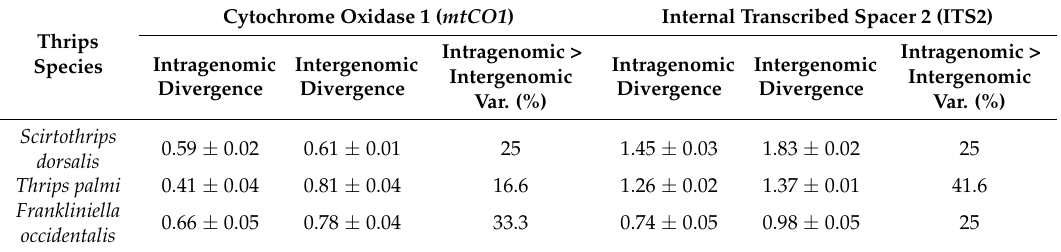
Table 2. Percentage mean nucleotide divergence ( ± standard error among unique clones from the same individual (intragenomic variation) and clones of different individuals of the same species (intergenomic variation). Column 4 and 7 is the frequency among individual comparisons where intragenomic variation exceeds a corresponding intergenomic variation.